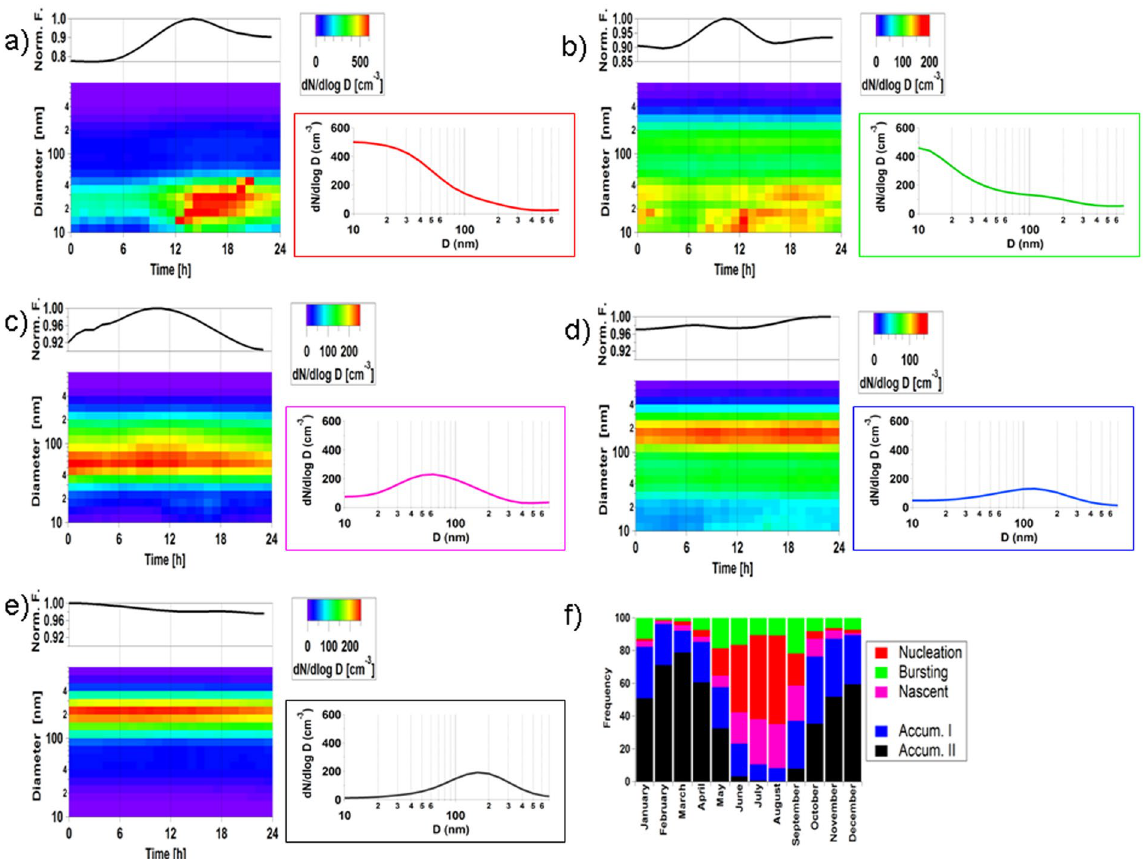
Figure 1. ( a–e ) Daily aerosol size distributions cluster results (bottom), average Daily N 10–500 particle number concentration (top) and average daily size distribution (on the right coloured panel); and ( f ) annual frequency distributions of the five aerosol categories. New particle formation events were also validated by N 3–10nm concentrations (measured by tandem particle counters with lower detection limits of 3 and 10 nm, respectively; see methods) of 316 ± 110, 168 ± 58, 128 ± 44, 73 ± 25, 99 ± 36 cm − 3 for clusters ( a–e ),